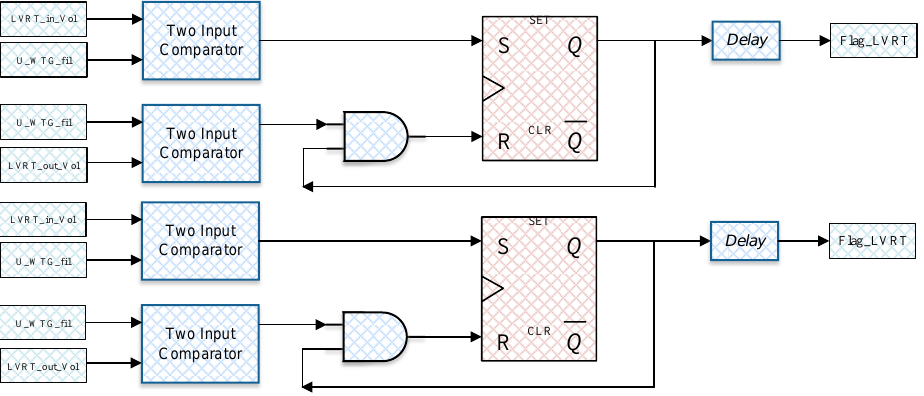
Figure 7. Control blocks of deadband protection.